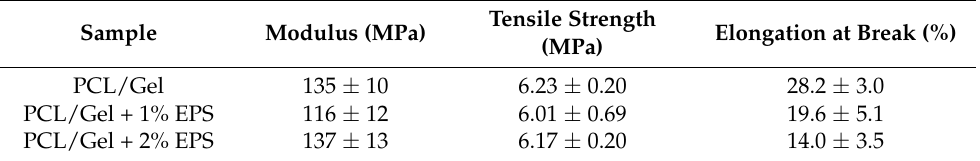
Table 1. Tensile properties of PCL/Gel blend nanofiber containing 0–2% EPS.